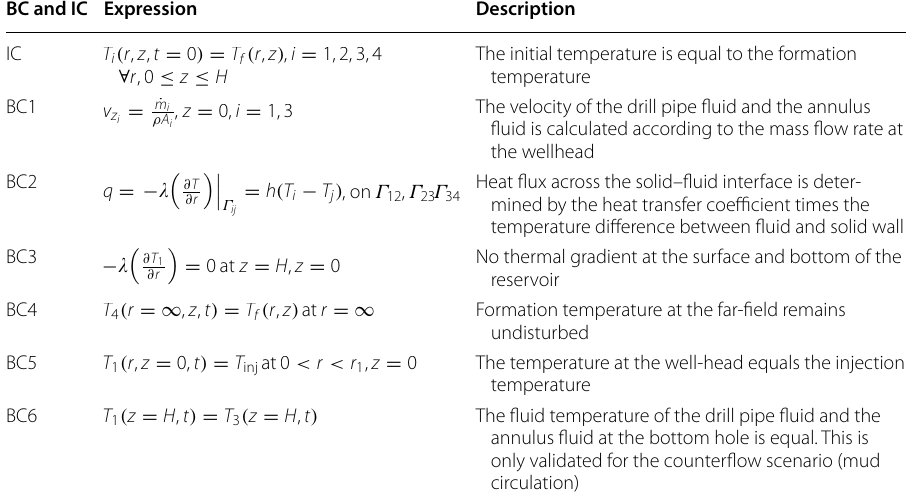
A i is the flow cross‑section, Г ij is the interfacial area between the fluid and solid structures, e.g., drill pipe, casing and formation, H is the well depth, T f (r,z) is the formation temperature, T inj is the injection temperature of the fluid, h is the heat transfer